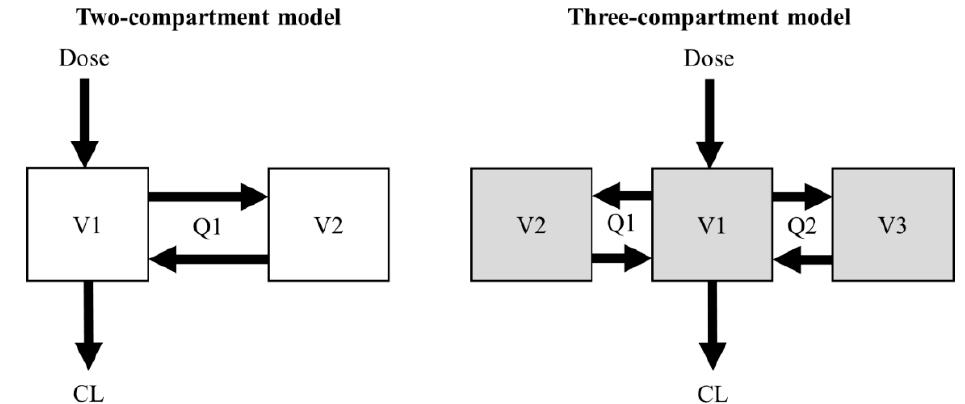
Figure 1. Structural design of the two- and three-compartment models.